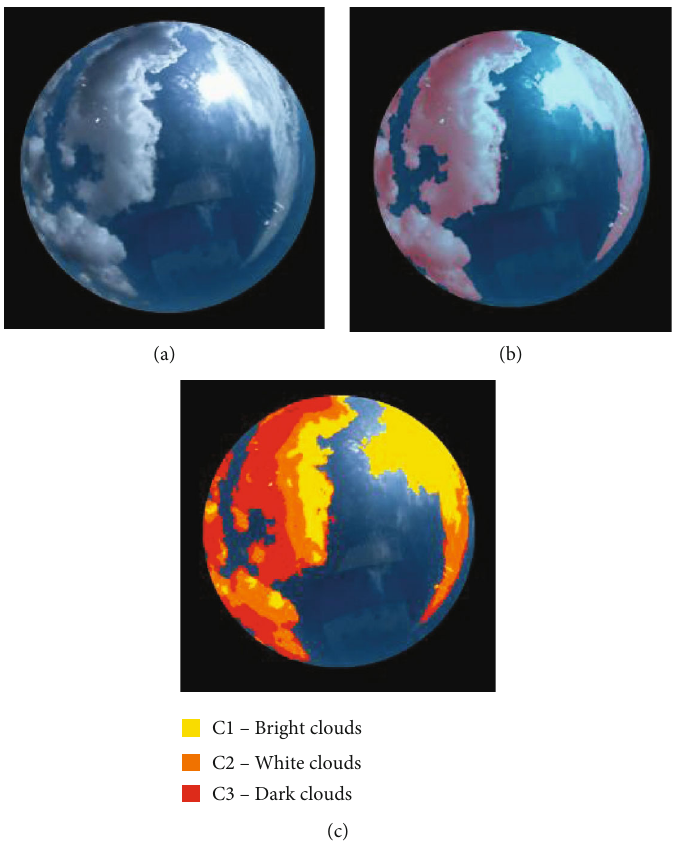
Figure 11: (a) Raw RGB image, (b) identi fi ed white and grey areas are marked on the raw RGB image, and (c) classi fi ed cloud pixels from the cloud categorization